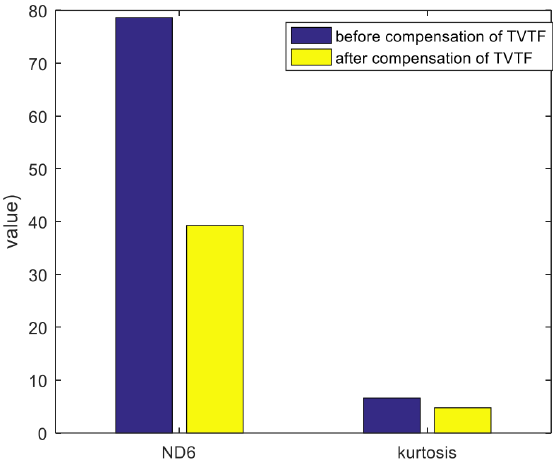
Figure 10. Kurtosis and ND6 value before and after compensation of the TVTF.